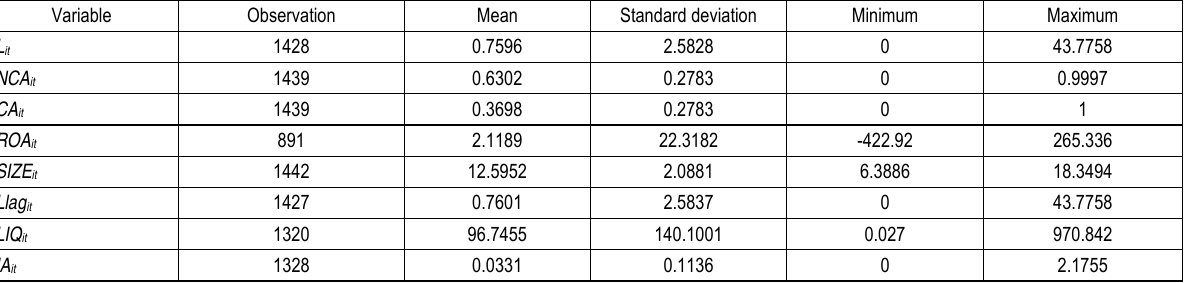
Table 13. Descriptive statistics, Model V